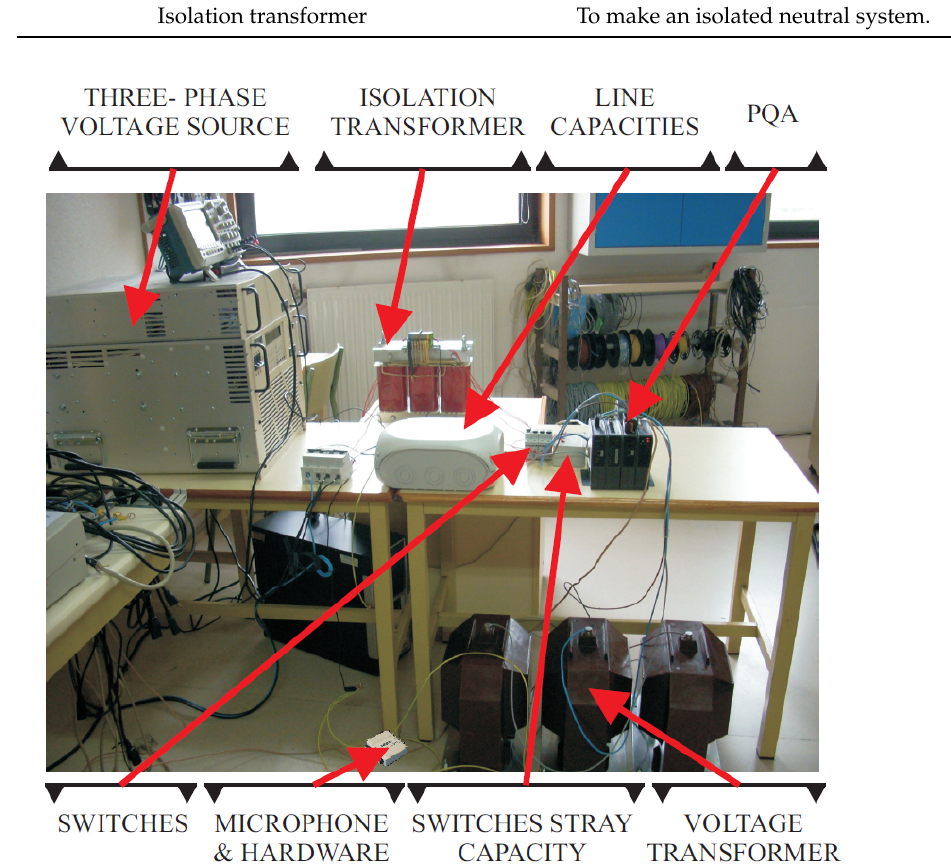
Figure 11. System